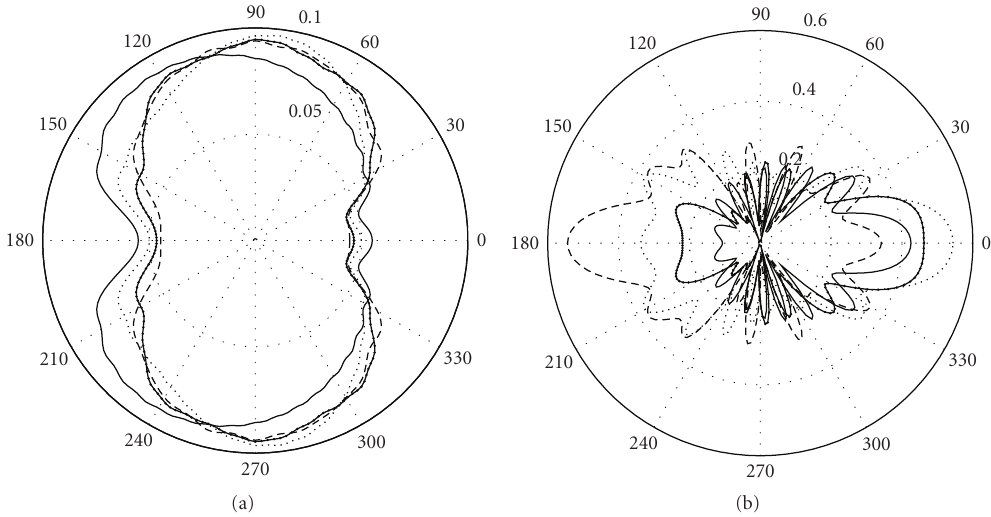
Figure 2: Radiation patterns of elements 1(-), 2(:), 4(.-) and 8(- -) in arrays of 17 elements. (a) without eigenmodes, (b) with eigenmodes. The horizontal axis corresponds to the array